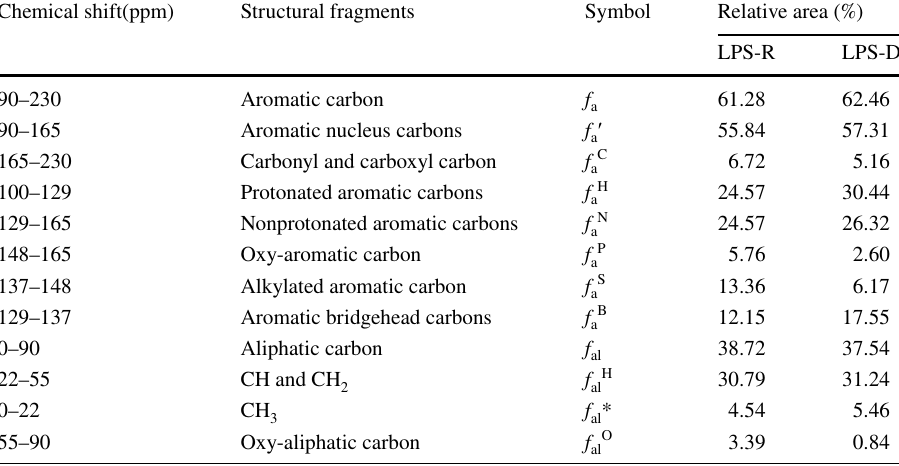
Chemical shift(ppm)